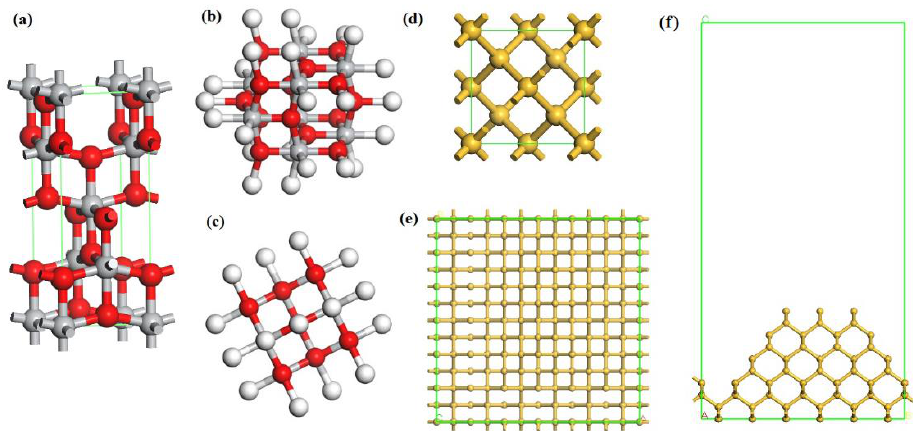
Figure 2. Calculated structures of anatase TiO 2 cluster model and monocrystalline silicon surface. ( a ) Unit cell of TiO 2 , ( b ) Top view, and ( c ) side view of TiO 2 cluster where white, red and grey are hydrogen, oxygen and titanium atoms, respectively; ( d ) Unit cell of Si; ( e ) Top view, and ( f ) side view of Si (100) surface.